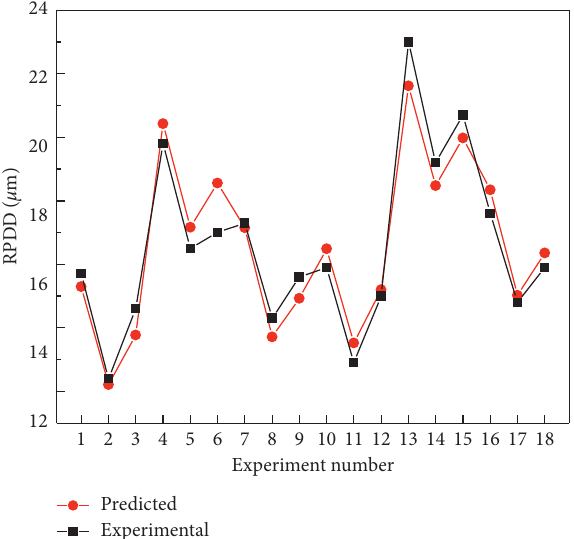
Figure 7: Comparison between experimental and predicted values.